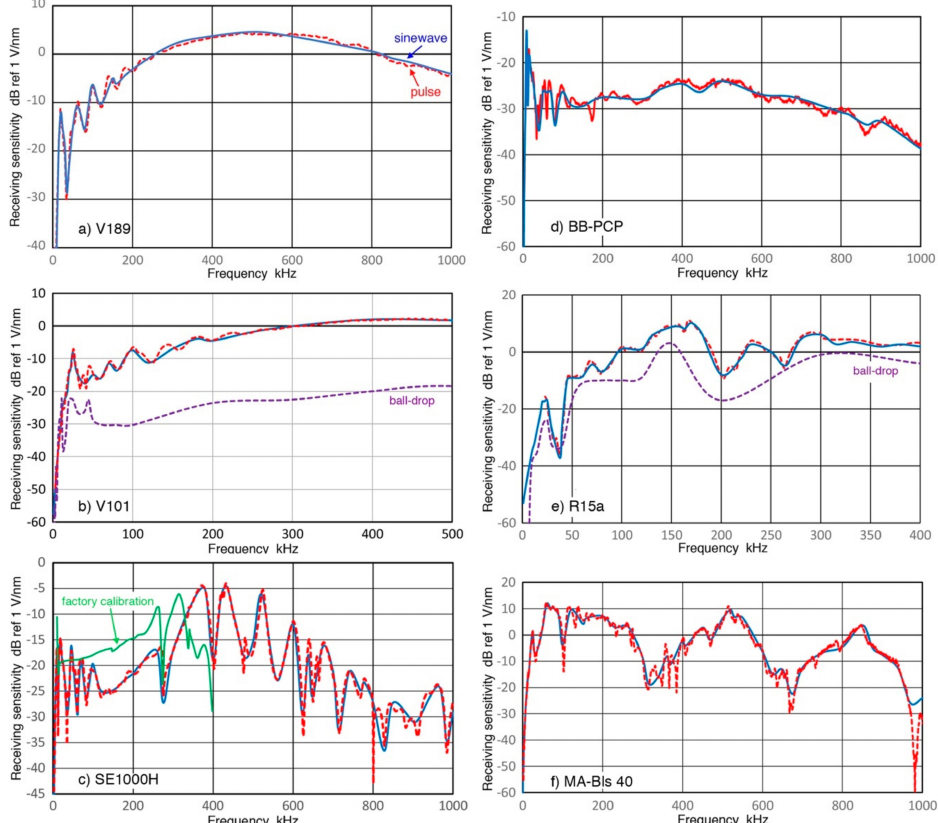
Figure 9. ( a ) Two sensitivity curves for V189 (Z in = 1 M Ω ) from Figure 8 are plotted in linear frequency scale in kHz. Receiving sensitivity spectra for sinewave (blue curve) and pulse (red dash curve) methods in dB scale as in Figure 8; ( b ) Same as in ( a ) for V101 from Figure 11; ( c ) Same as in ( a ) for SE1000H from Figure 12; ( d ) Same as in ( a ) for KRN BB-PCP from Figure 13; ( e ) Same as in ( a ) for R15a from Figure 14; ( f ) Same as in ( a ) for MA-Bls-40 from Figure